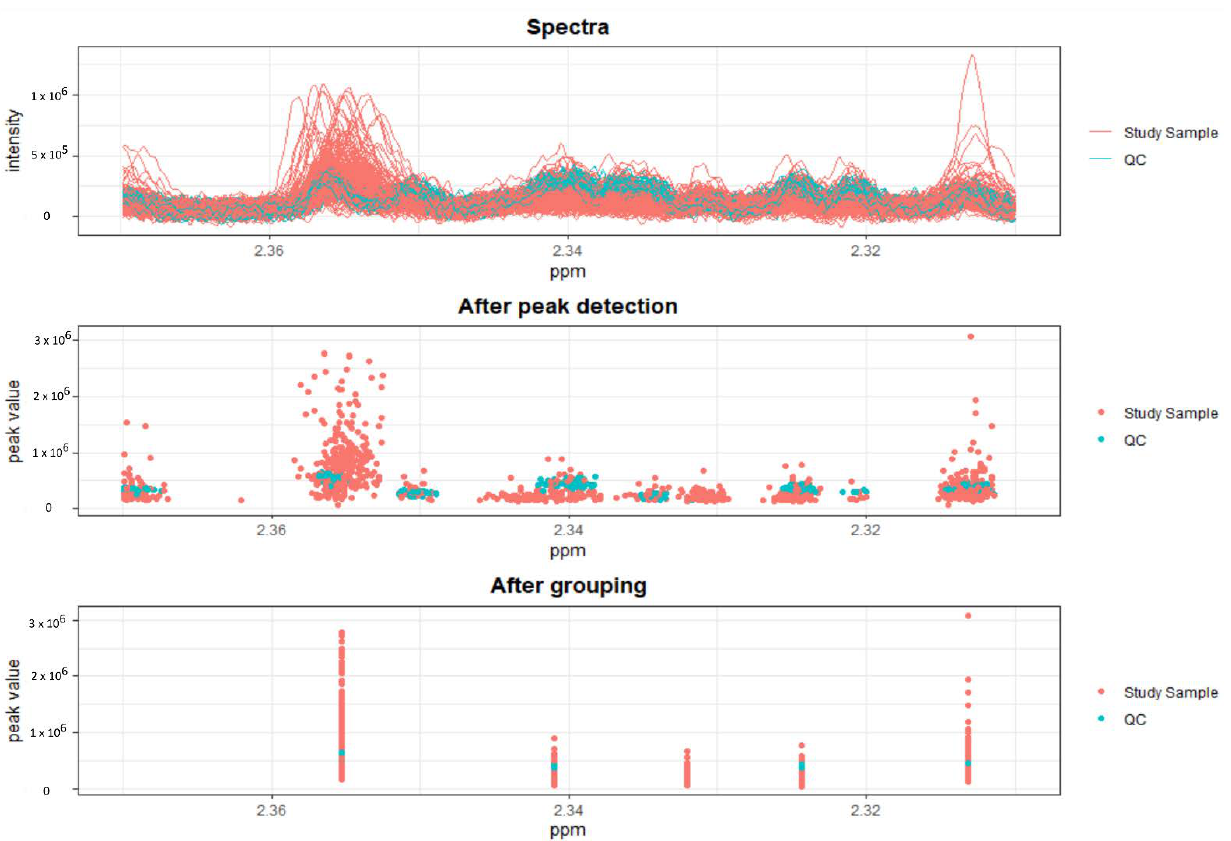
Figure 1. Results obtained after peak picking, as well after grouping and filling of the NMR spectra. Only the first half of samples analyzed are depicted.